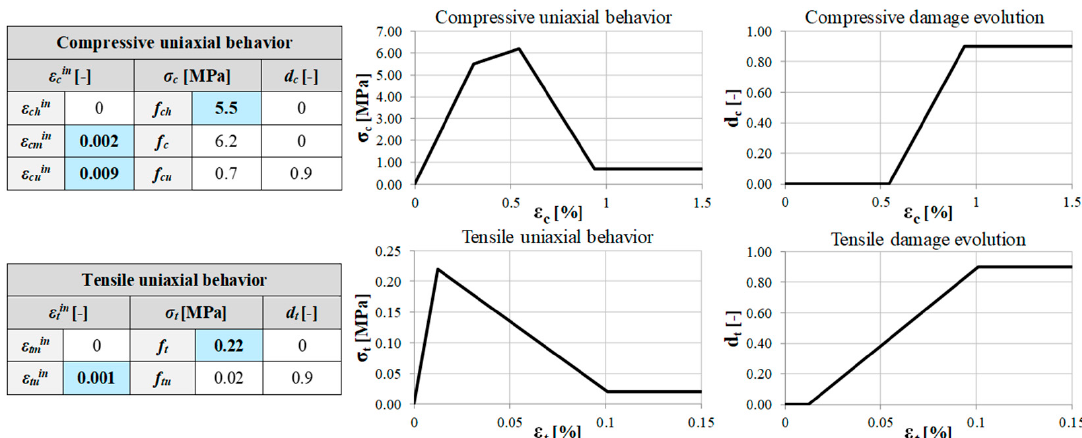
Figure 5. Uniaxial behavior for the compressive and tensile regimes determined through the cali- bration for the CDP model and summary of adopted parameters (where f t - tensile strength of the material and f ch - uniaxial compressive stress corresponding to the point of initial yield; ε cm - value of uniaxial compressive strain corresponding to the reaching of the maximum strength; ε cu - value of the uniaxial compressive strain corresponding to the end of the softening branch).